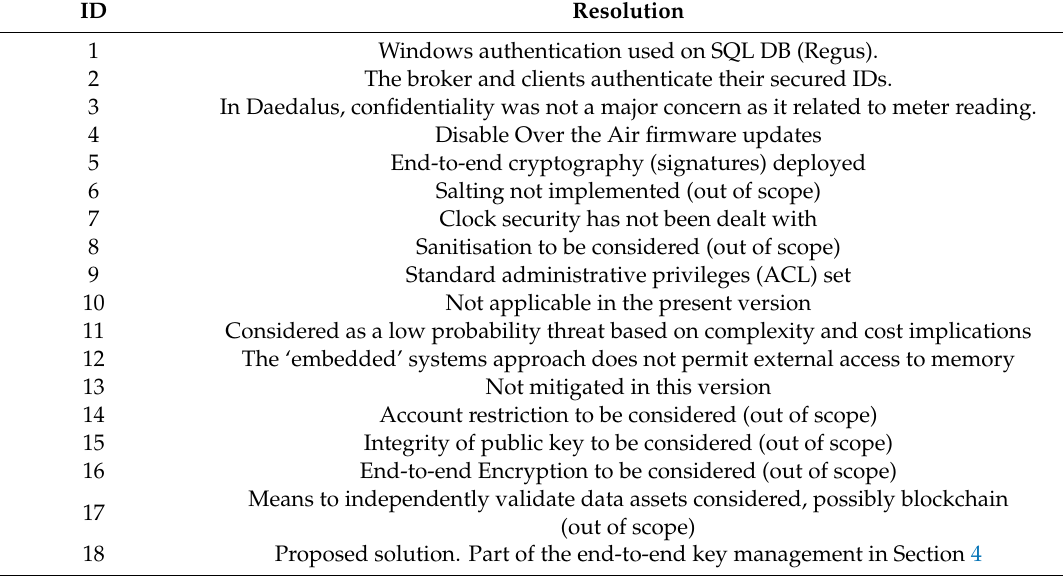
Table 5. Resolutions for the threat events in DREAD determined during the first phase of